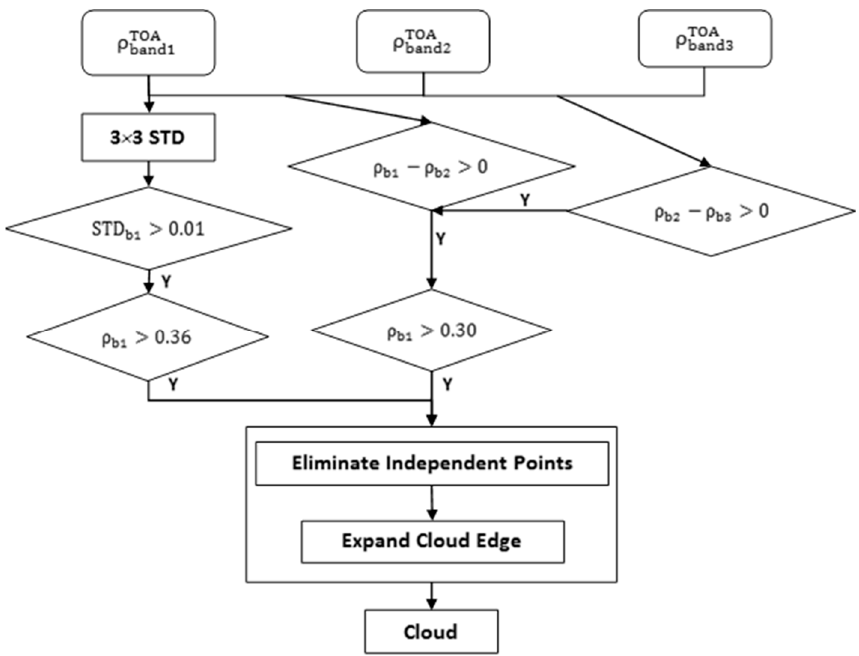
Figure 4. GF ‐ 1/WFV cloud recognition